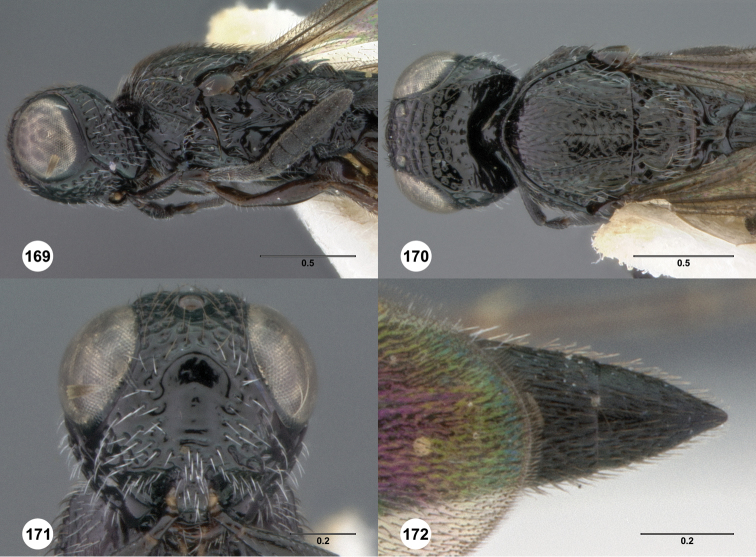
Oxyscelio linguae sp. n., holotype female (OSUC 448567) 169 Head and mesosoma, lateral view 170 Head and mesosoma, dorsal view 171 Head, anterior view 172 Metasoma, dorsal view. Morphbank60